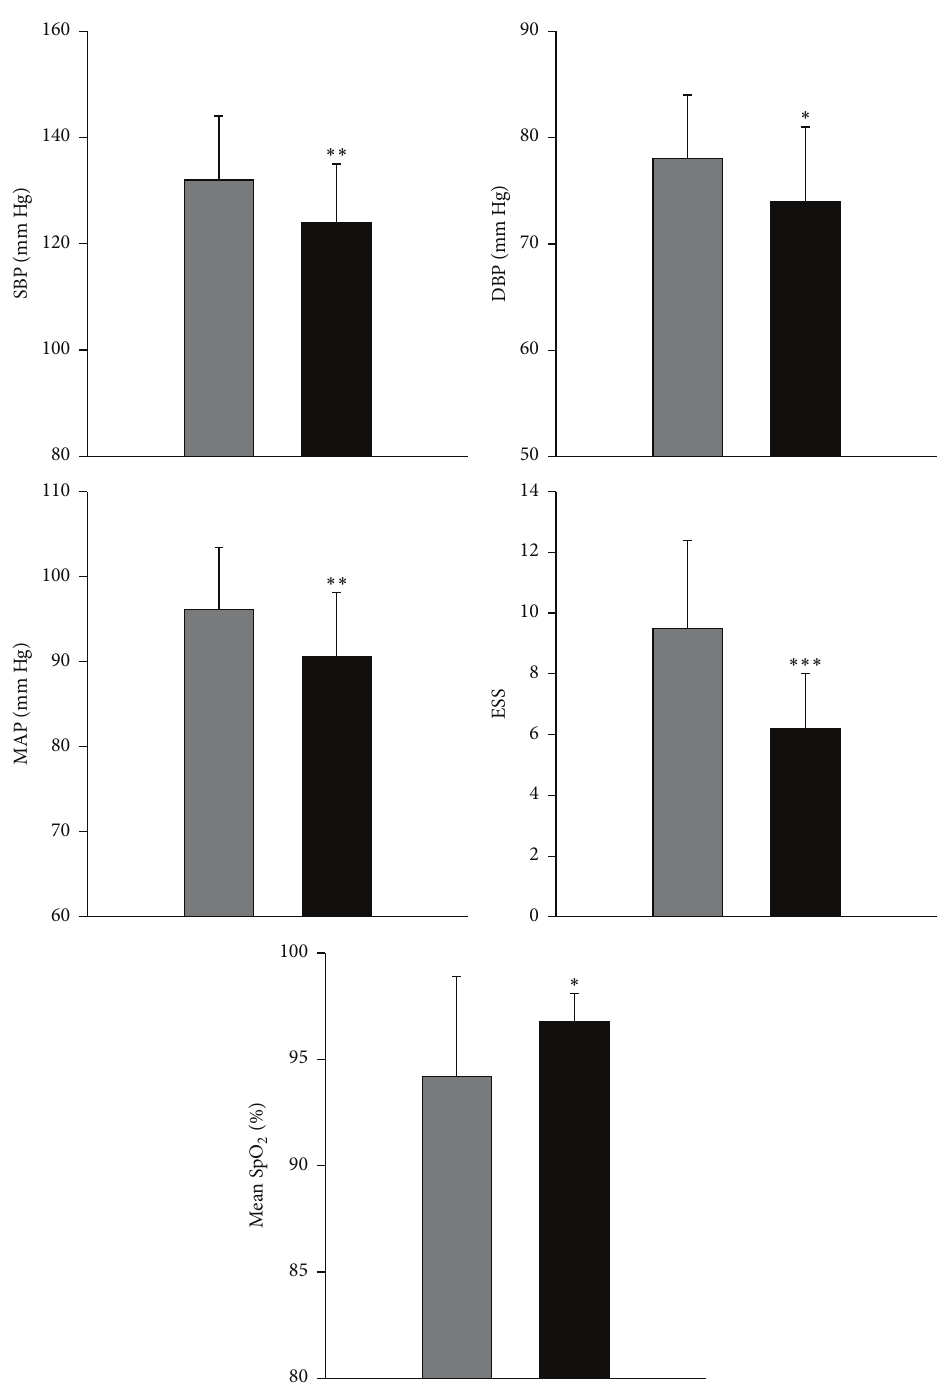
Figure 1: Systolic blood pressure (SBP), diastolic blood pressure (DBP), mean arterial pressure (MAP), Epworth Sleepiness Scale (ESS), and mean oxygen saturation (mean SpO 2 ) in 13 obstructive sleep apnea (OSA) patients before and after continuous positive airway pressure (CPAP) therapy. ∗ 𝑃 < 0.05 , ∗∗ 𝑃 < 0.01 , and ∗∗∗ 𝑃 < 0.001 pre- versus post-CPAP